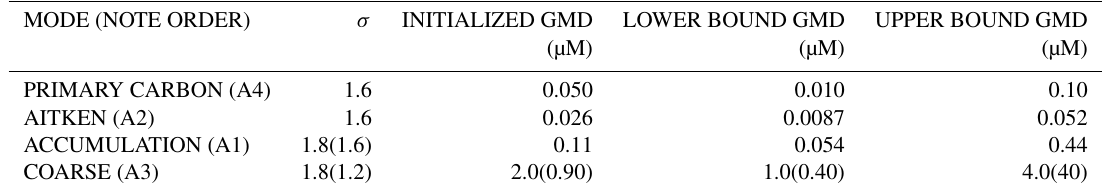
Table 1. Mode parameters for the Modal Aerosol Module version 4 (MAM4) used in CAM5 (CAM5 size) and CAM6.1 (CAM6 size) by default: geometric standard deviations ( σ ) and initialized geometric mean diameter (GMD) and its ranges. Values in parentheses if present are for CAM6.1; cells without parentheses are kept the same between CAM5 and